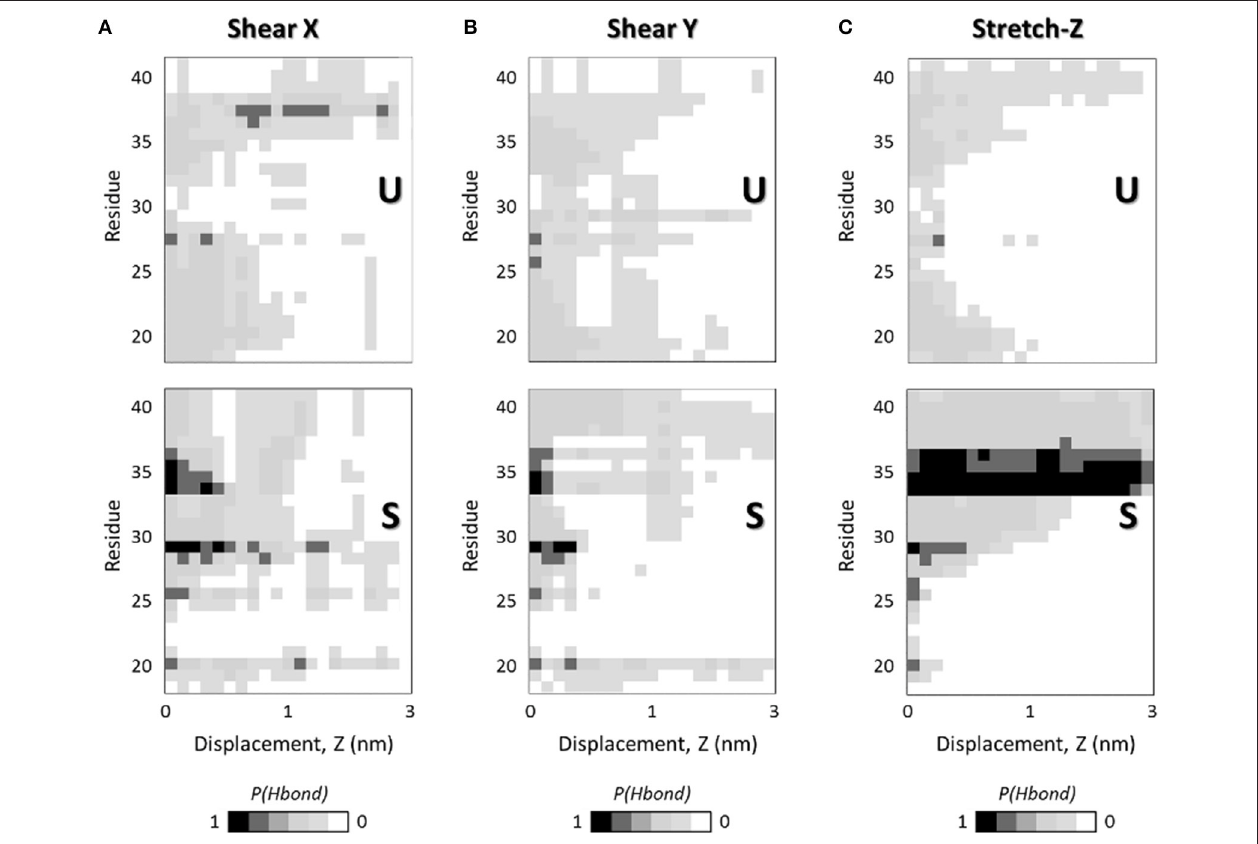
FIGURE 4 | Interchain H-bonds (between chain B and chain C) as function of the interchain chain displacement in (A) X-, (B) Y-, and (C) Z-direction along the SMD simulations at pulling rate v = 0.01 Å/ps. Plots show the probability of H-bonds presence as function of interchain displacement in case of U- (top) and S-shaped (bottom) arrangements. For each residue in one chain (e.g., chain B) the presence of H-bonds with the adjacent chain (e.g., chain C) is quantified as a probability calculated over 5 SMD replicas. Black color indicates a probability of 1, whereas the white code represents a probability of 0, as reported in the